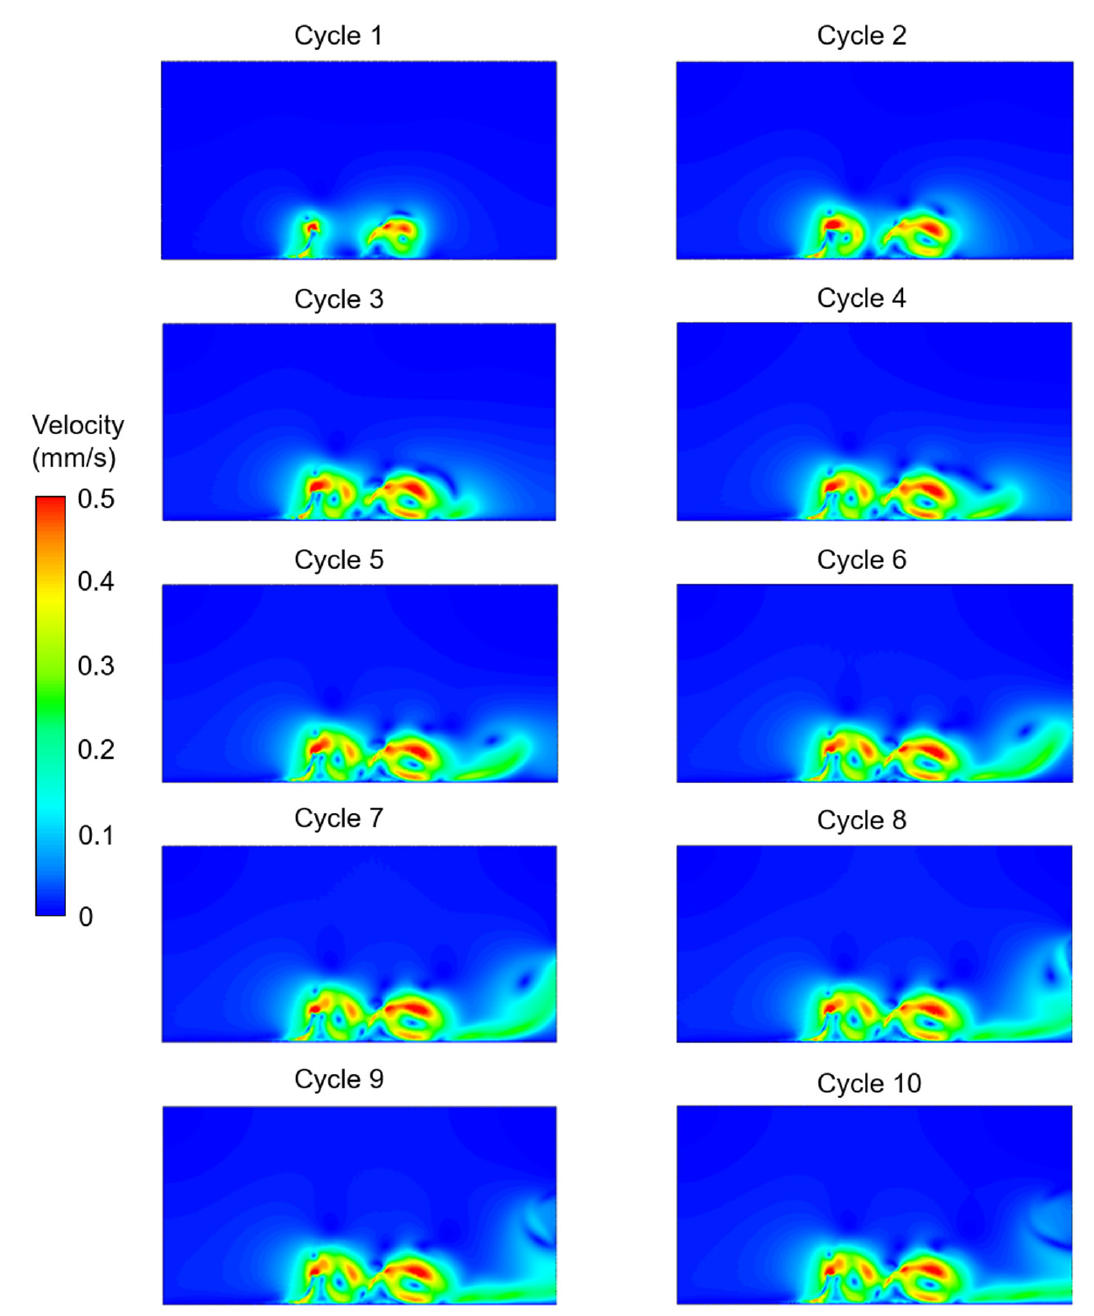
Figure 7. Velocity contour plots of Case 5 for two cilia with a 60° cilium tilt angle. The cilia beat with a phase difference (out of phase). One of the cilia completes the cyclic motion when the other one is at half of the cyclic movement. The flow fields are provided at the end of each ciliary cycle. The amount of mass flow rate was determined on the right-side line of the flow domain at each cycle and presented in Figure 8. For Case 1 (one cilium, 30 ◦ cilium tilt angle), a backflow was observed at the third and fourth cycles. For cases 2, 3, 4, and 5, there was no backflow at any instant during the ten cycles. The average mass flow rates during ten ciliary beating cycles were determined as approximately 0.05, 0.30, 0.39, 0.18, and 0.54 µ g/s, for the cases 1, 2, 3, 4, and 5, respectively. The maximum mass flow rates during the ten investigated cycles were determined as approximately 0.20, 0.49, 0.61, 0.40, and 0.84 µ